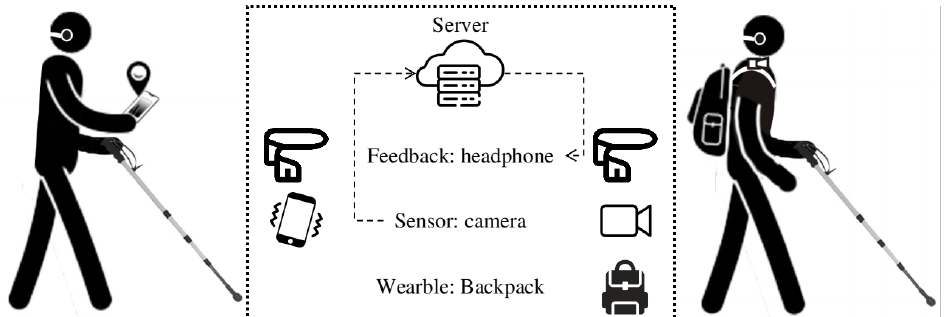
Figure 6. Two types of end-user interfaces. On the left is an infographic that demonstrates the use of our Android application. The user selects the desired destination and sends it to the server. For localization, the end user touches the screen (or waits for the time interval) to capture a query image, which is sent to the cloud server. The server then calculates the camera pose and sends instructions to the end user via a binaural bone-conduction headset. On the right is an infographic that demonstrates the use of our wearable device with a binaural bone-conduction headset. During navigation, a camera (cid:114) connected to a backpack-mounted NVIDIA Jetson AGX Xavier captures and sends query images to a cloud server; the user receives navigation instructions via the headset.